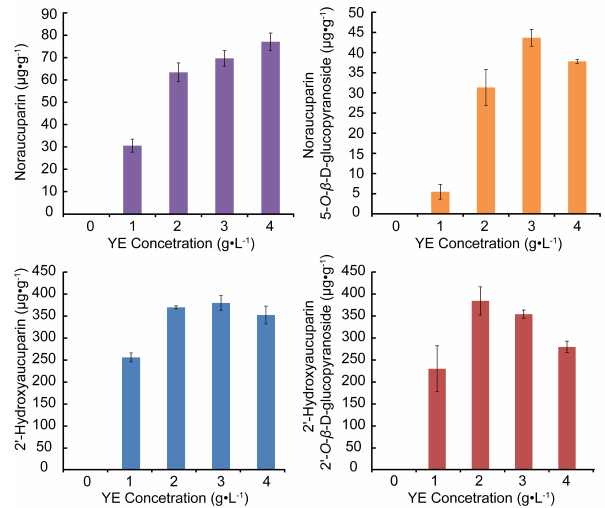
Figure 6. Analyses of contents of four biphenyl biomarkers with different concentrations of YE in S. pohuashanensis suspension cells. Values are means of three independent experiments. Bars represent standard